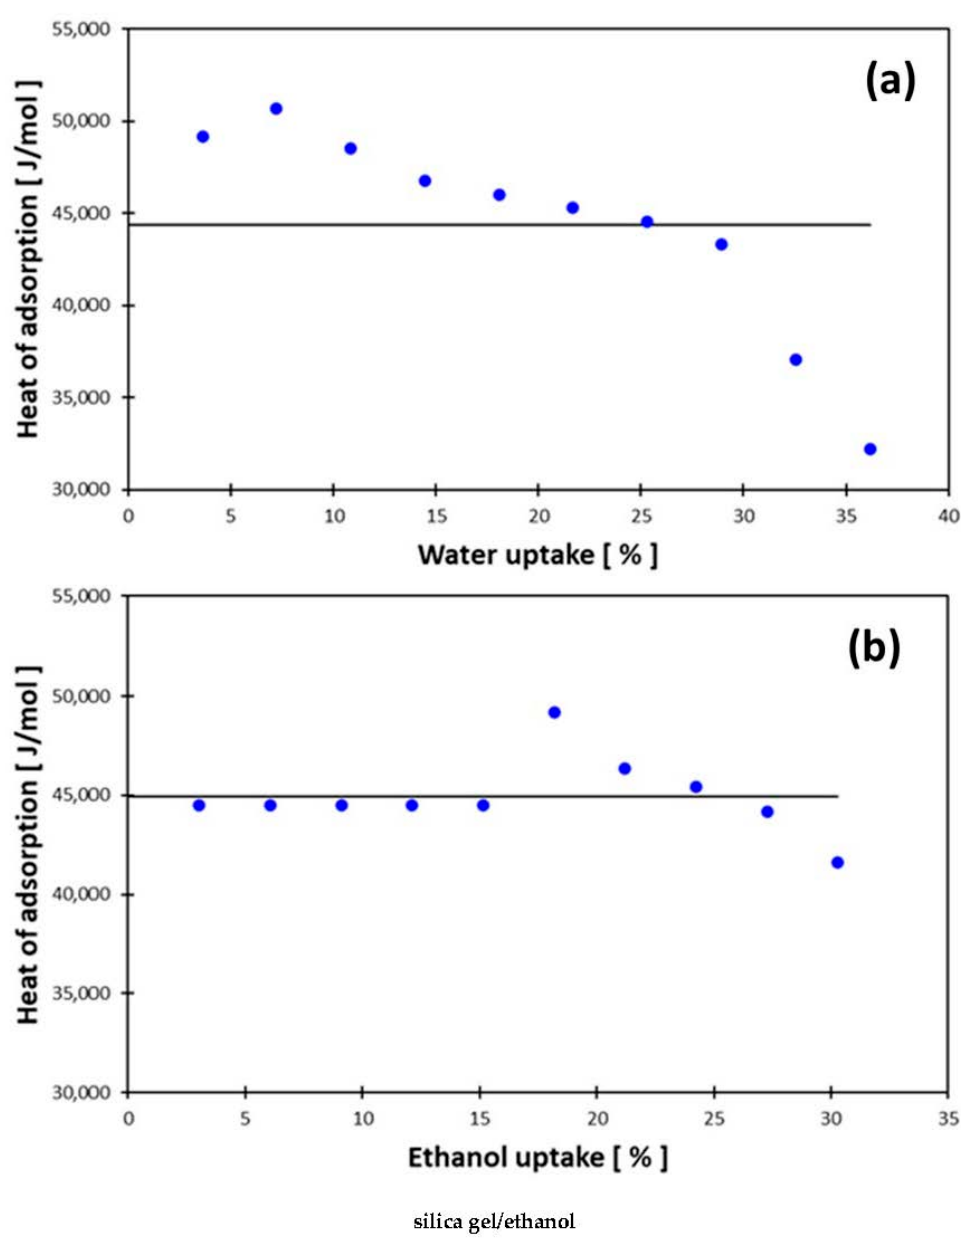
Figure 3. Plot the isosteric heat of adsorption versus the surface coverage of the ( a ) silica gel/water and ( b ) silica gel/ethanol.